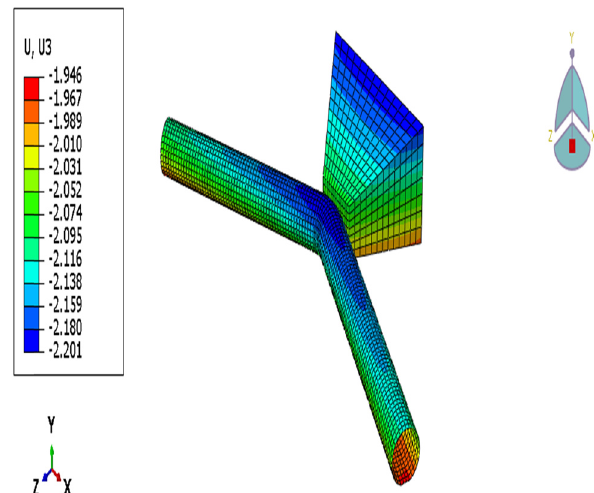
Figure 22: Horizontal displacement of thrust block ( mm ) .